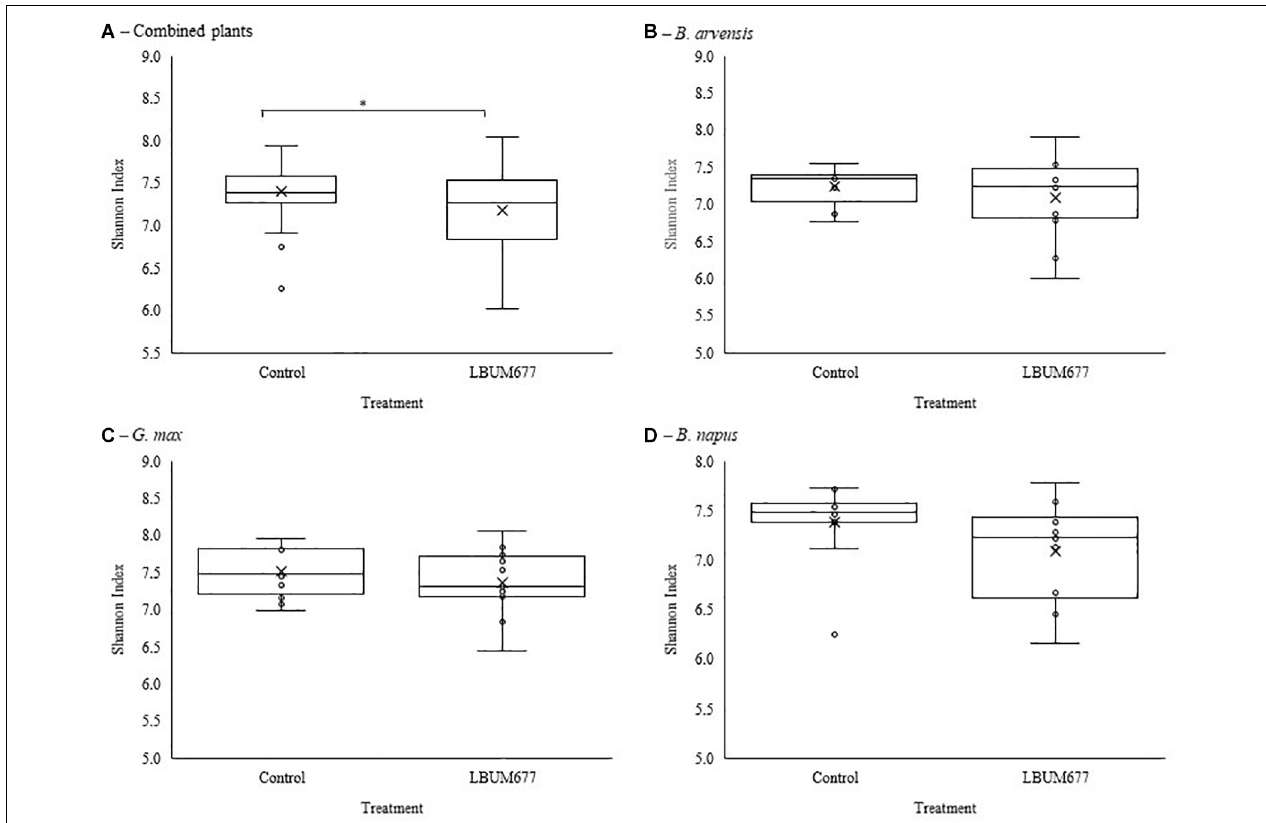
FIGURE 3 | Treatment variations of alpha-diversity metrics in the bacterial microbiome of three oil-producing crops. (A) Alpha-diversity metric (Shannon’s index) of treatment variations for all plants and sampling dates combined. (B) Alpha-diversity metric (Shannon’s index) of treatment variations for B. arvensis plants and sampling dates combined. (C) Alpha-diversity metric (Shannon’s index) of treatment variations for G. max plants and sampling dates combined. (D) Alpha-diversity metric (Shannon’s index) of treatment variations for B. napus plants and sampling dates combined. Kruskal-Wallis pair-wise test was used to assess statistical significance between groups (* p <